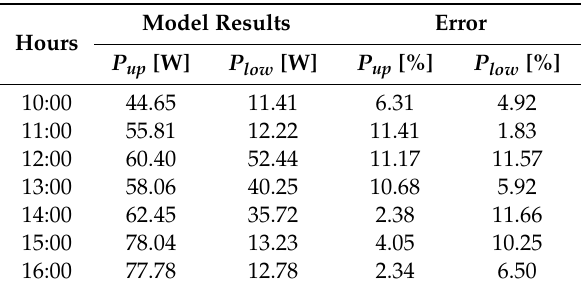
Table 1. Results obtained by the developed PowerCollector ™ model for the non-cooling experiment. Hours